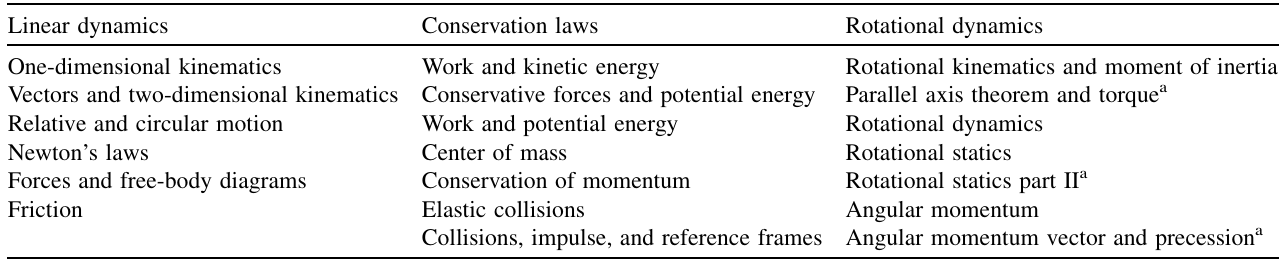
TABLE I. List of MLM prelecture topics used in this